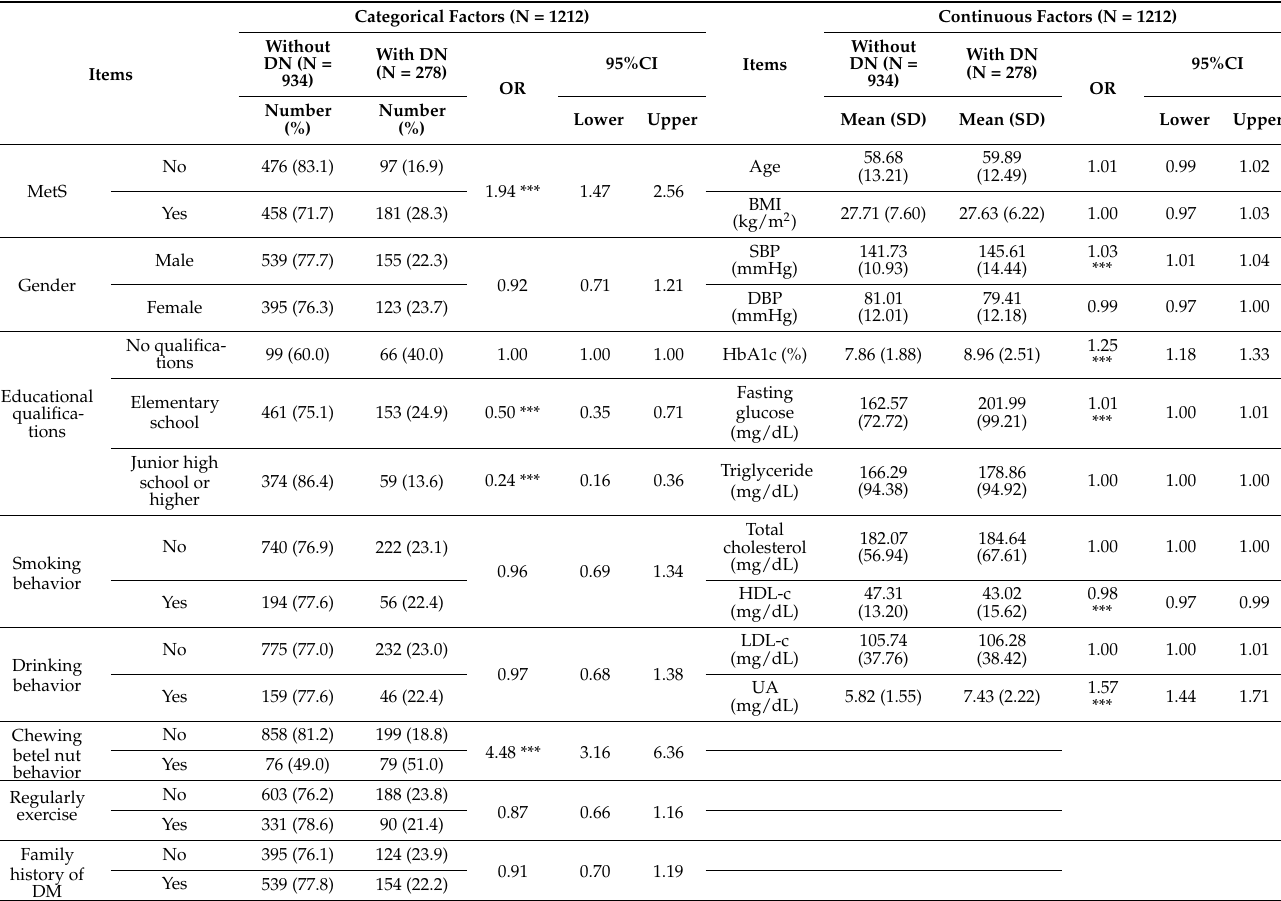
Table 1. Comparisons of categorical and continuous factors of DN for all T2DM patients (N =